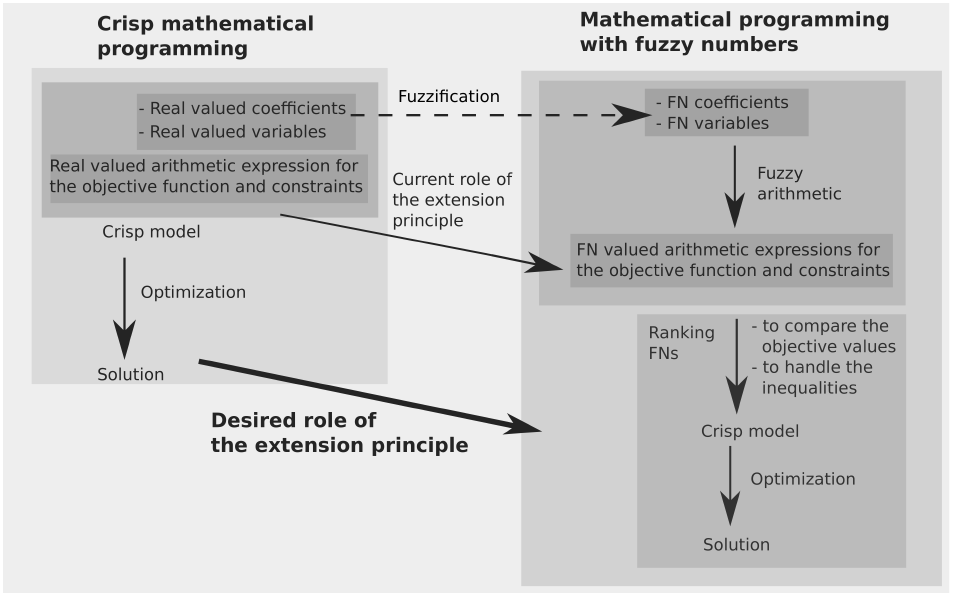
Figure 2. Current versus desired roles of the extension principle in mathematical programming with fuzzy